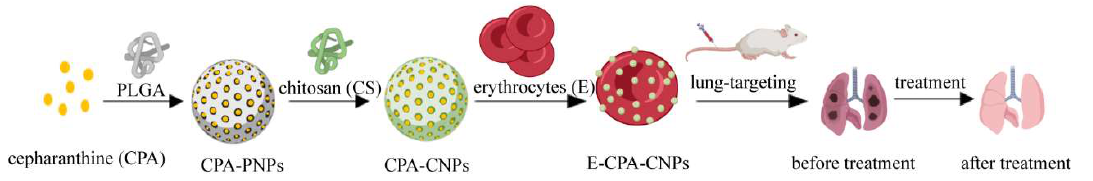
Figure 1. Schematic diagram of an erythrocyte-anchoring strategy. CPA-CNPs were prepared and bound to erythrocytes in a non-covalent manner. After injection into ALI mice, CPA was delivered to the lung to alleviate inflammatory damage.